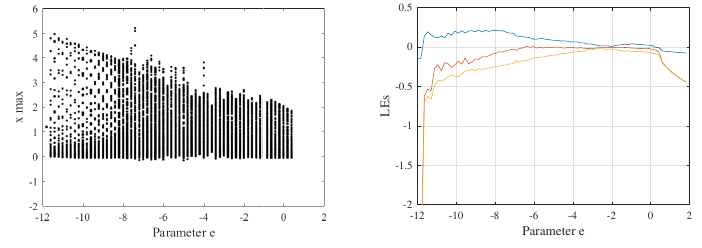
Figure 2. Bifurcation diagrams ( left ) and Lyapunov exponent spectrum ( right ) for System